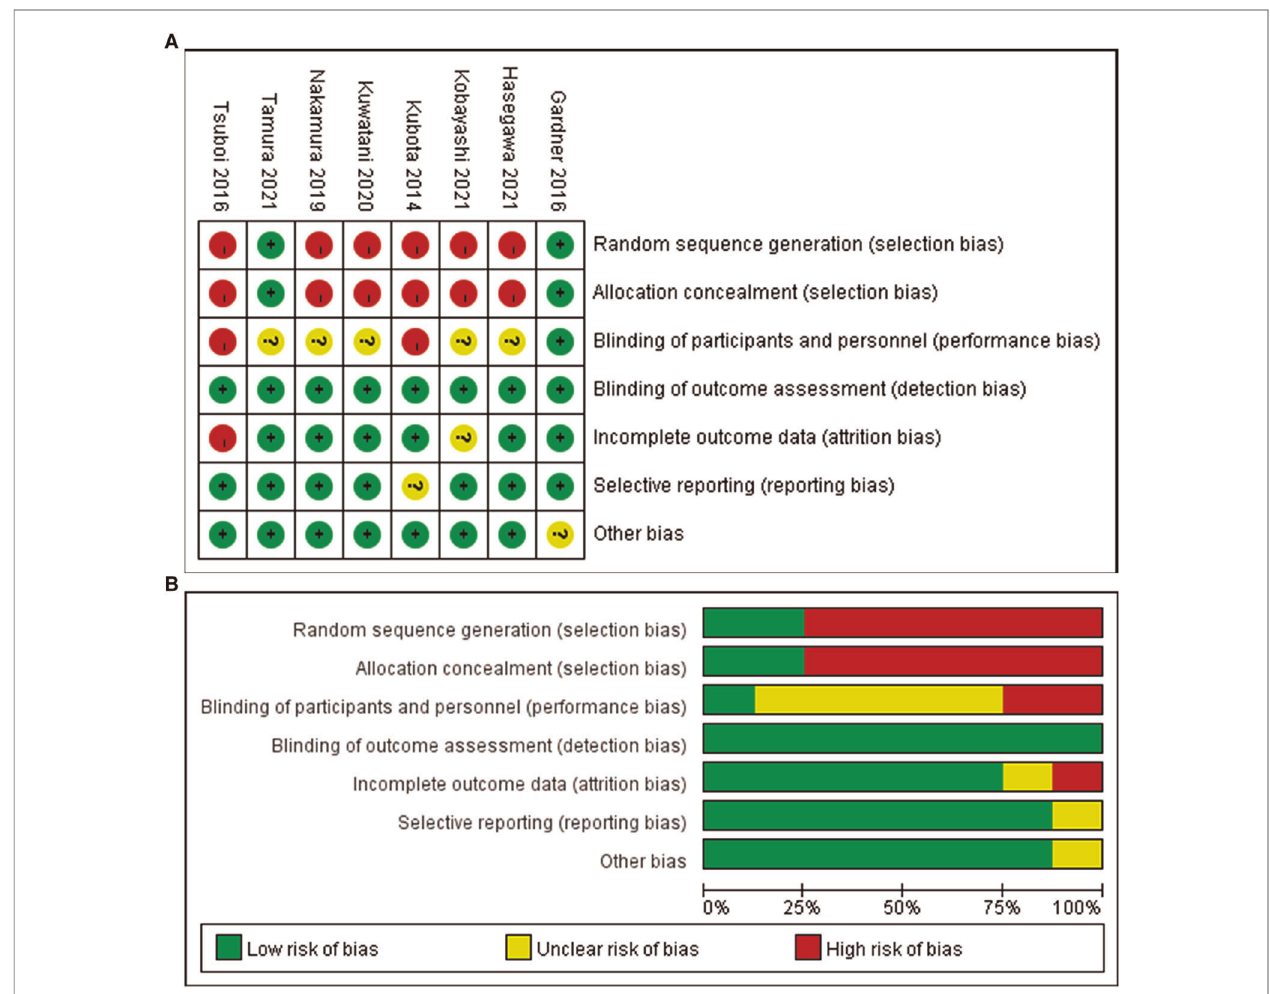
FIGURE 2 | Risk bias diagram of the included studies ( A ) Risk of bias summary; ( B ) Risk of bias